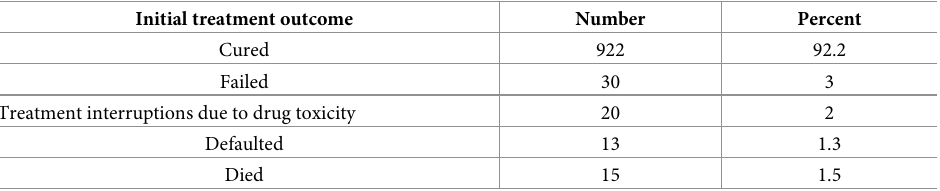
Table 2. Overall initial treatment outcomes of VL patients treated with SSG and PM combination from January 1, 2012, to June 30, 2019 (N = 1000). Initial treatment